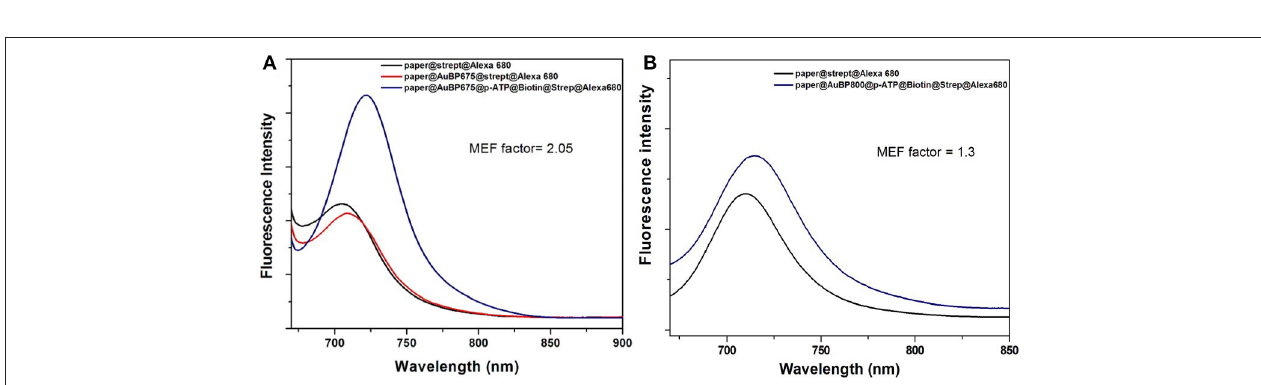
FIGURE 5 | Emission spectra of the streptavidin@Alexa 680 complex onto the biotinylated plasmonic lines (blue spectra), namely paper@AuBP675 (A) and paper@AuBP800 (B) together with the emission spectra of the streptavidin@Alexa 680 (black spectra) on bare Whatman paper (near the plasmonic lines). Excitation wavelength at